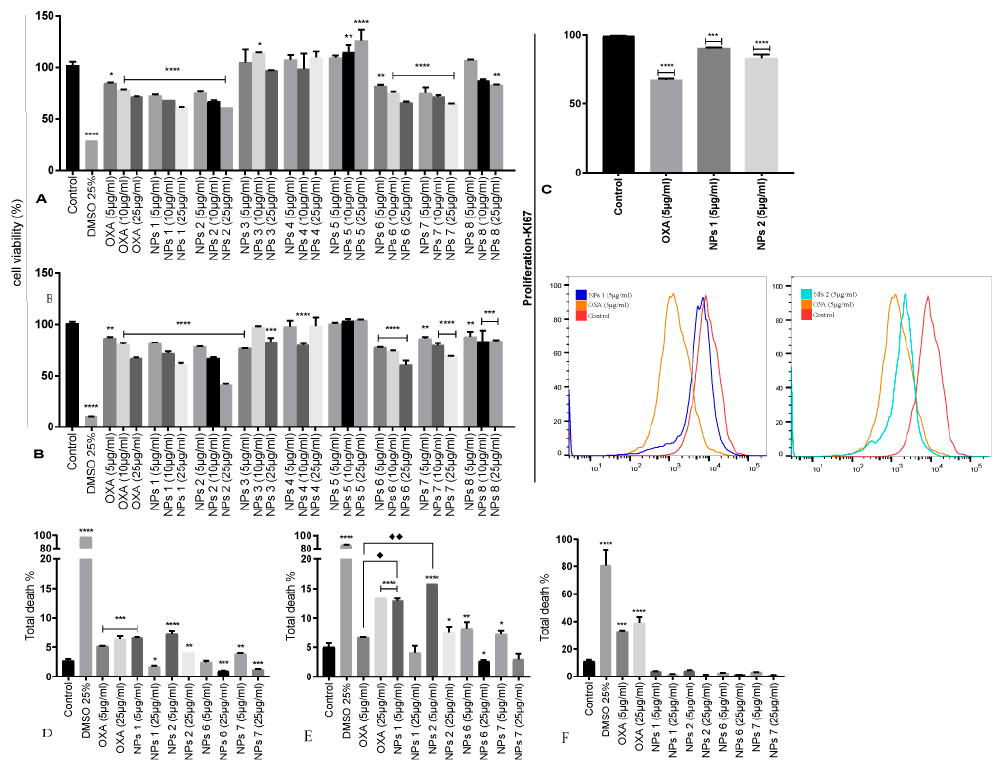
Figure 2. Cell viability ( A , B ), proliferation ( C ), total death for CT-26 for 24 h ( D ), total death for CT-26 for 48 h (E) and total death for 3T3 cells for 48 h ( F ). Mean cell proliferation of CT-26 cells treated with OXA and PLGA NPs for 24 h ( A ) and 48 h ( B ). Ki-67 immunostaining of CT-26 cells treated with OXA (5 µ g / mL), NPs 1 (5 µ g / mL), and NPs 2 (5 µ g / mL) and compared to negative control for 48 h ( C ). The statistic of the treatments for the total death when compared to the negative control is displayed (* p < 0.05, ** p < 0.01, *** p < 0.001, and **** p < 0.0001). Comparison between OXA (5 µ g / mL) and